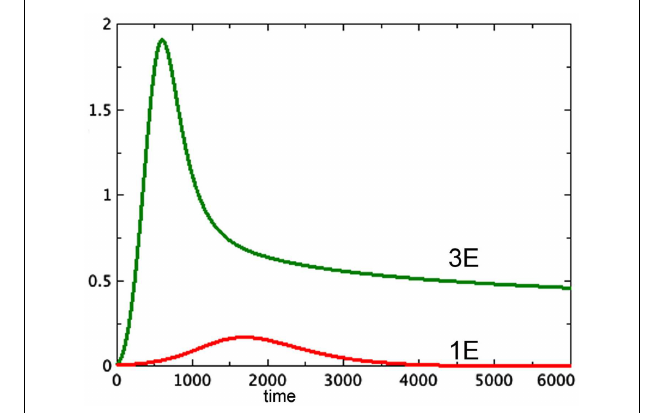
FIGURE 1 | Proliferating pools from models 3E and 1E compared. a = 0.01 , b P,Q = 0.01, c Q,P = 0.005, d = 0.002, e Q,N = 0.002, f = 0.01, h = 0, P 0 = 0.01, Q 0 = 0, N 0 =